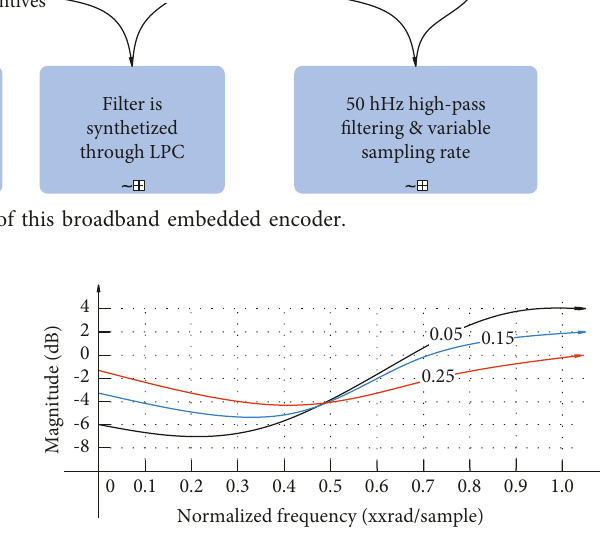
Figure 5: High-frequency enhancement filter c